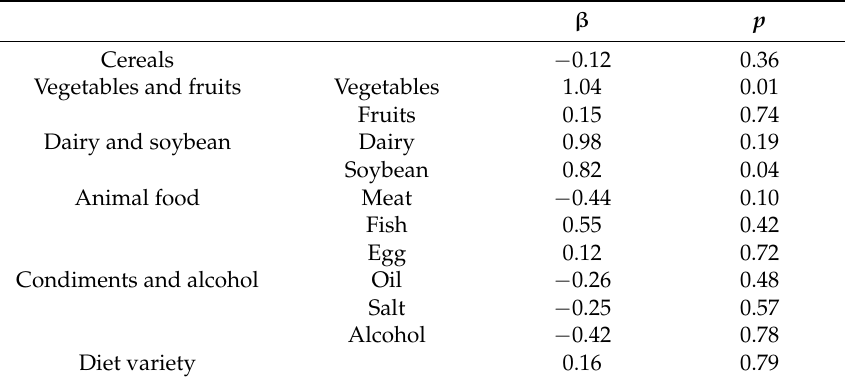
Table 6. Multivariable linear regression models for Hb levels by DBI-07 components.